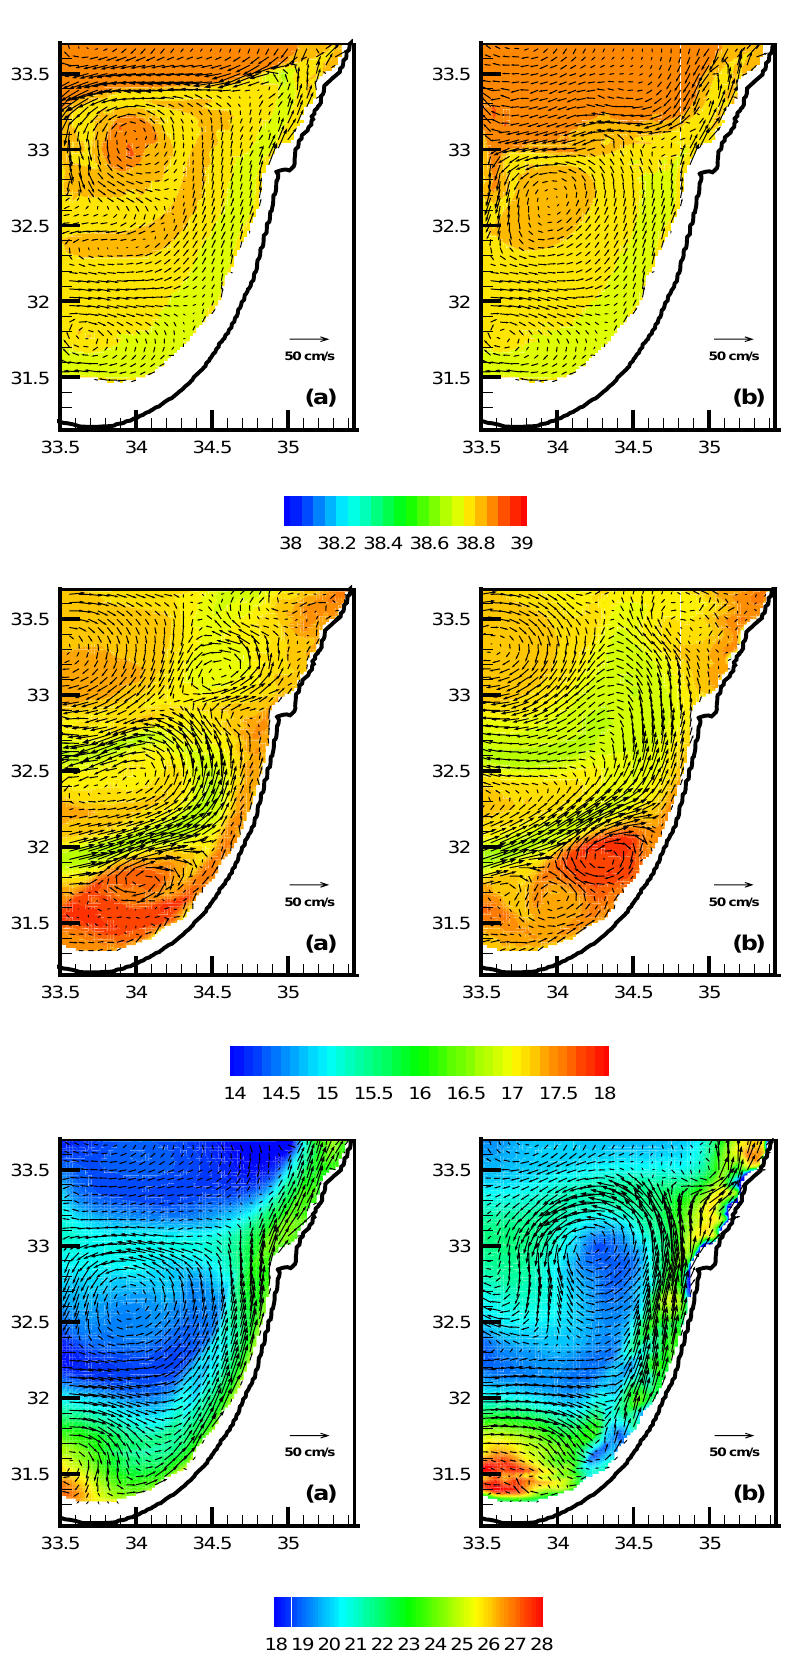
Fig. 9. Simulated potential temperature and velocity at 30m: (a) 10-day aver- age for 10–20 August of the third year, and (b) 10-day average for 10–20 Au- gust from the intermediate